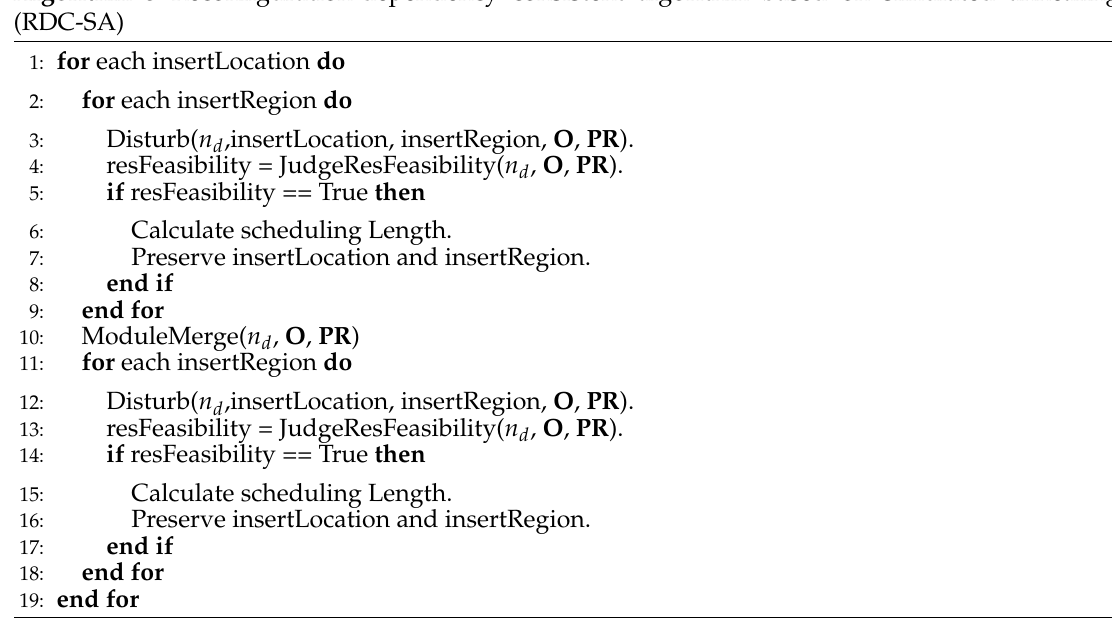
Algorithm 3 Reconfiguration-dependency consistent algorithm based on simulated